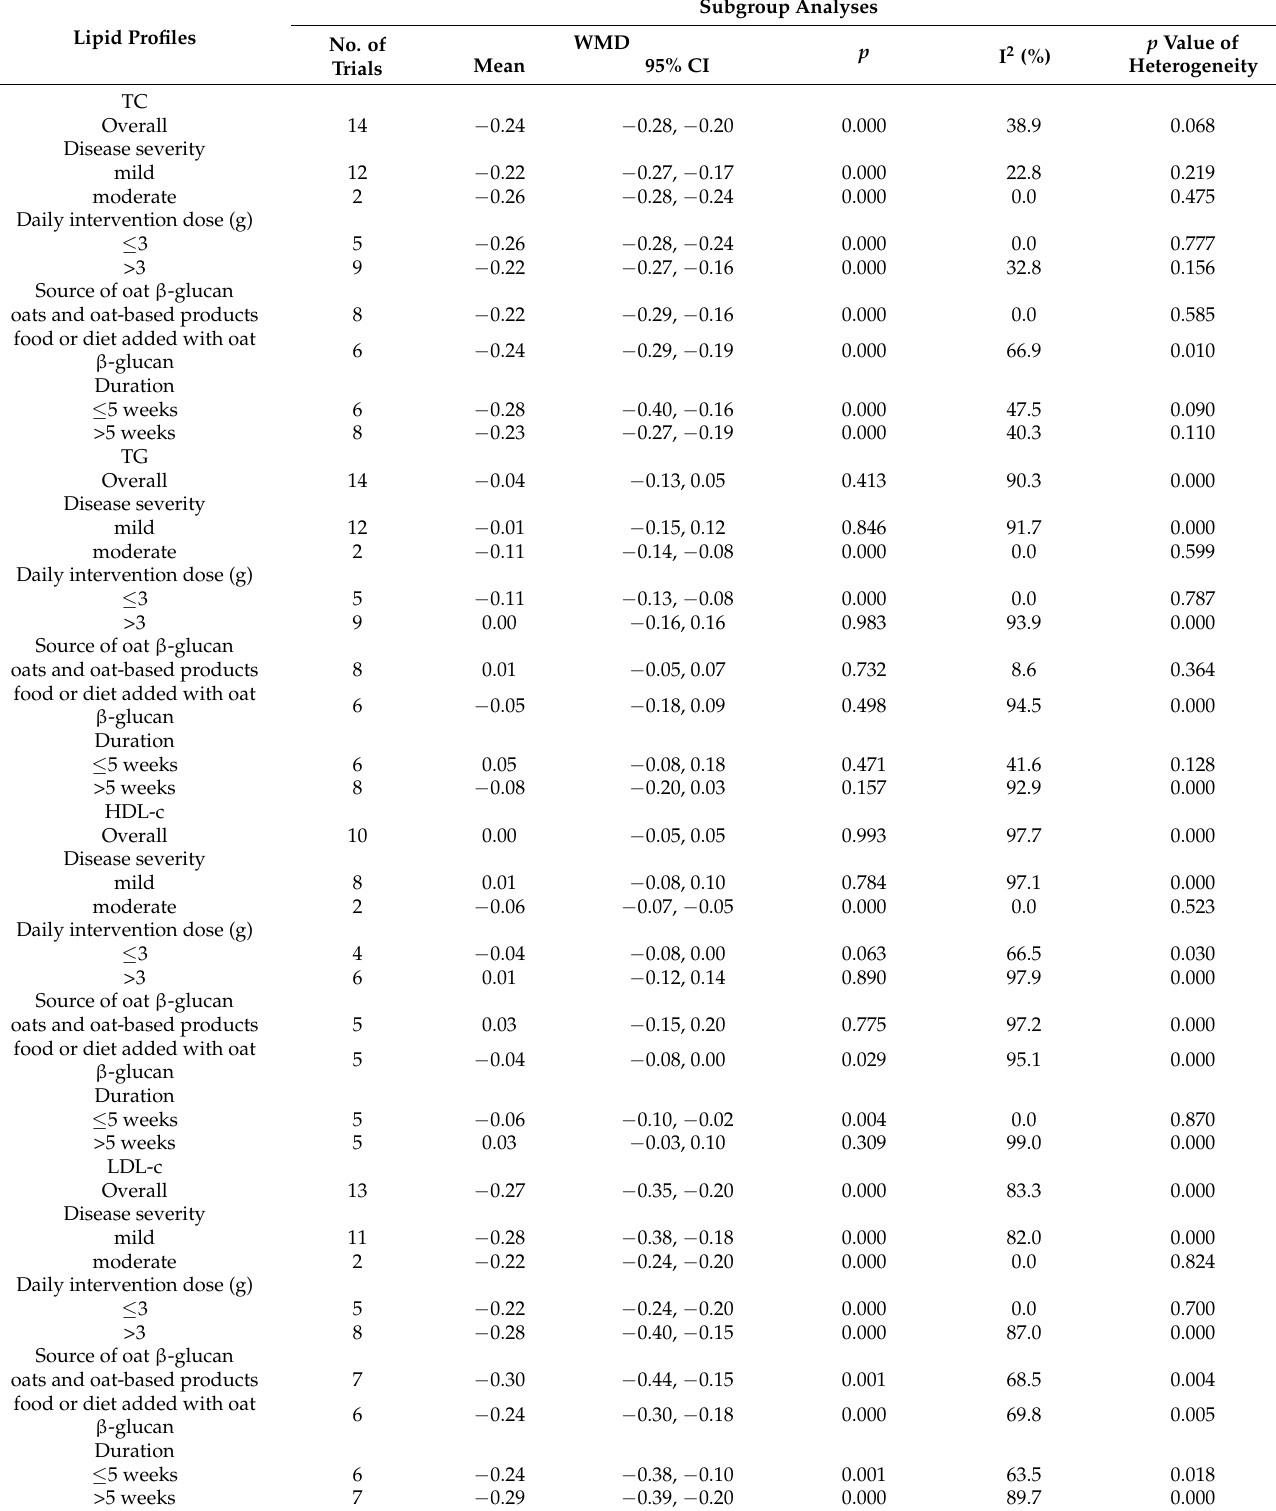
Table 3. Summary results of subgroup